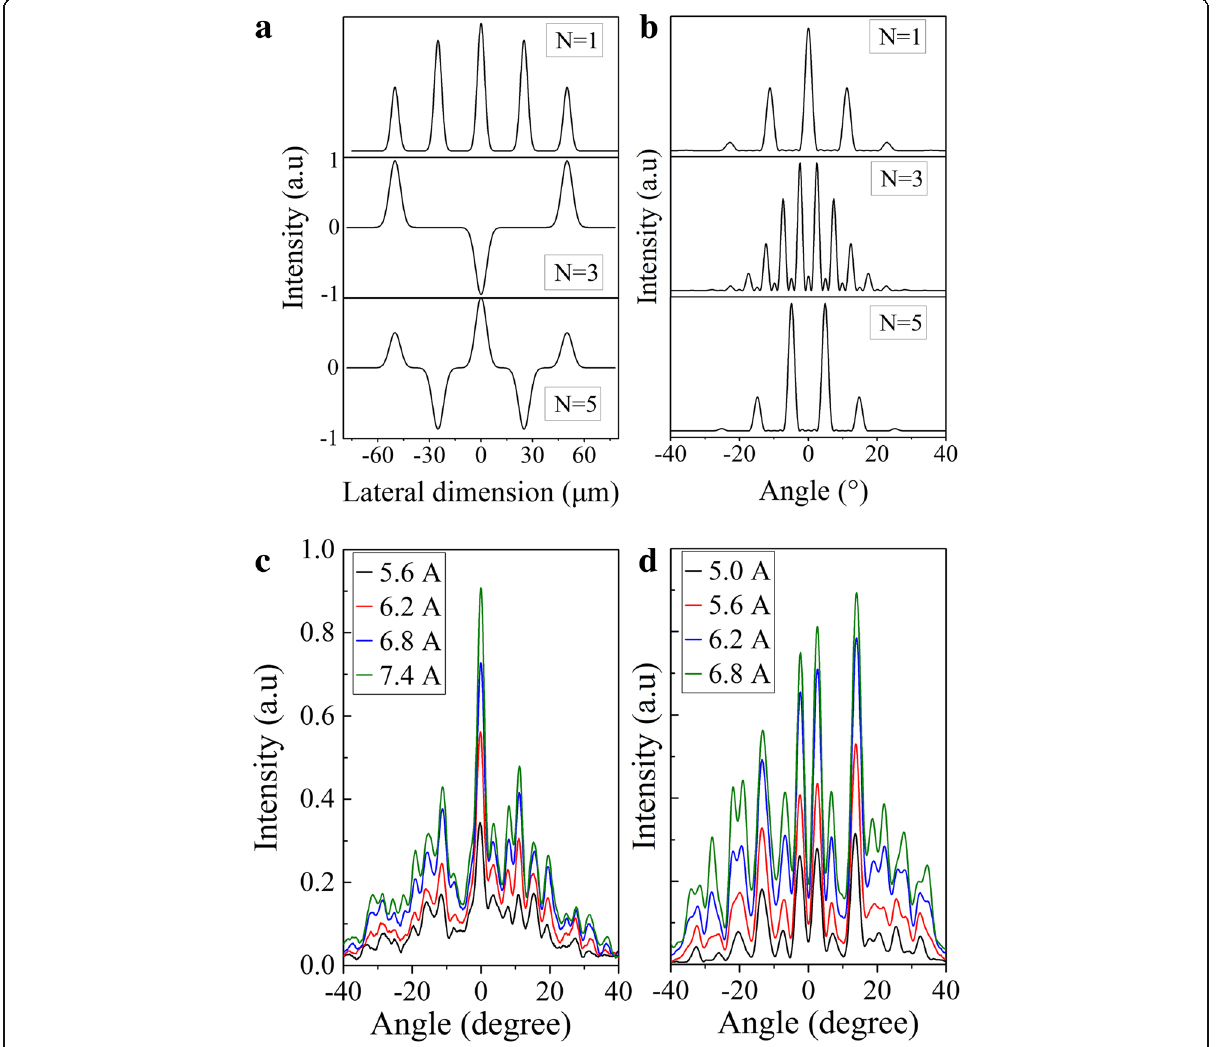
Fig. 3 a Calculated near-field patterns of the N = 1, 3, 5 order supermodes in a five-element diffraction-coupled array. The fundamental supermode ( N = 1) is calculated based on the straight-end connected to the Talbot cavity, and the high-order supermodes ( N = 3, 5) are based on taper connected to the Talbot cavity. b The simulated far-field patterns according to a . c The measured far-field distribution of QCL array with straight-end connected to a Talbot cavity. d The measured far-field distribution of QCL array with taper-end connected to a Talbot